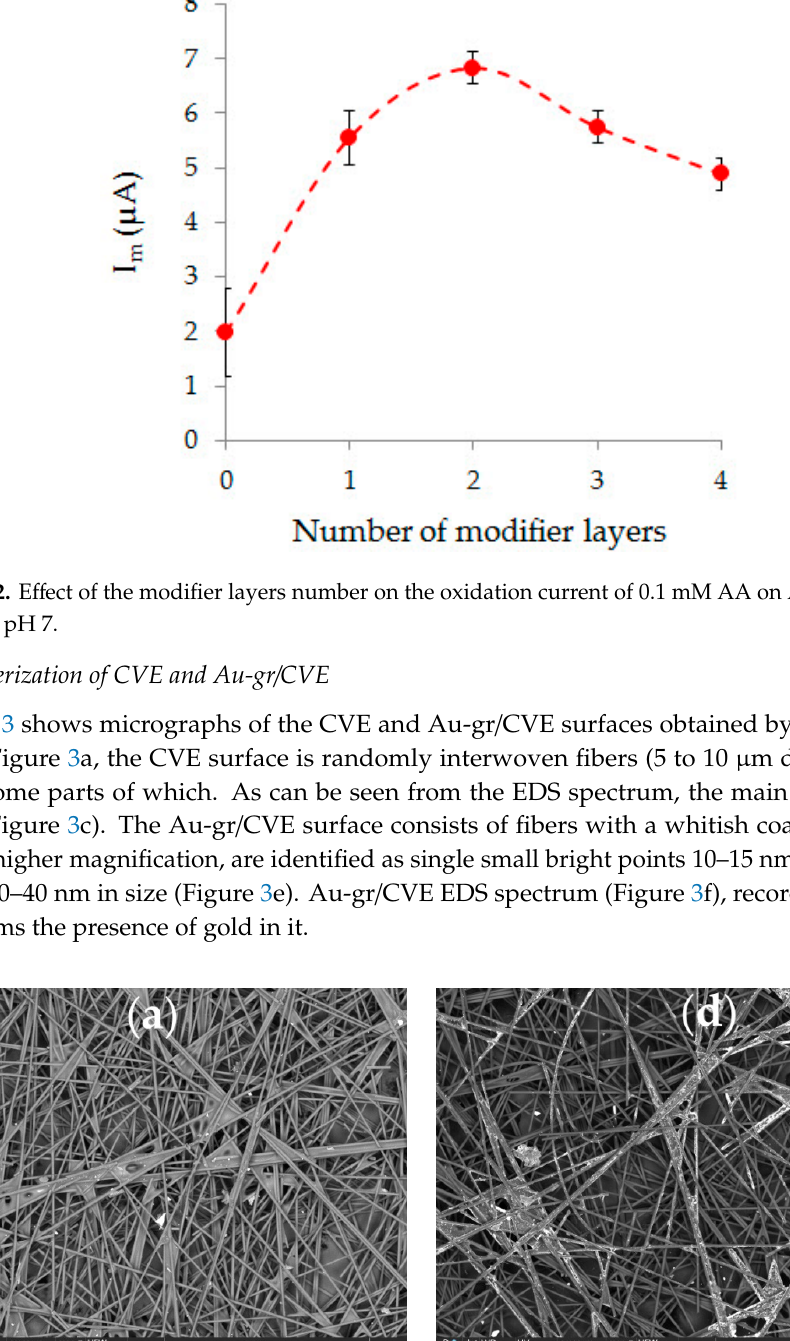
Figure 3. Cont. Figure 3.